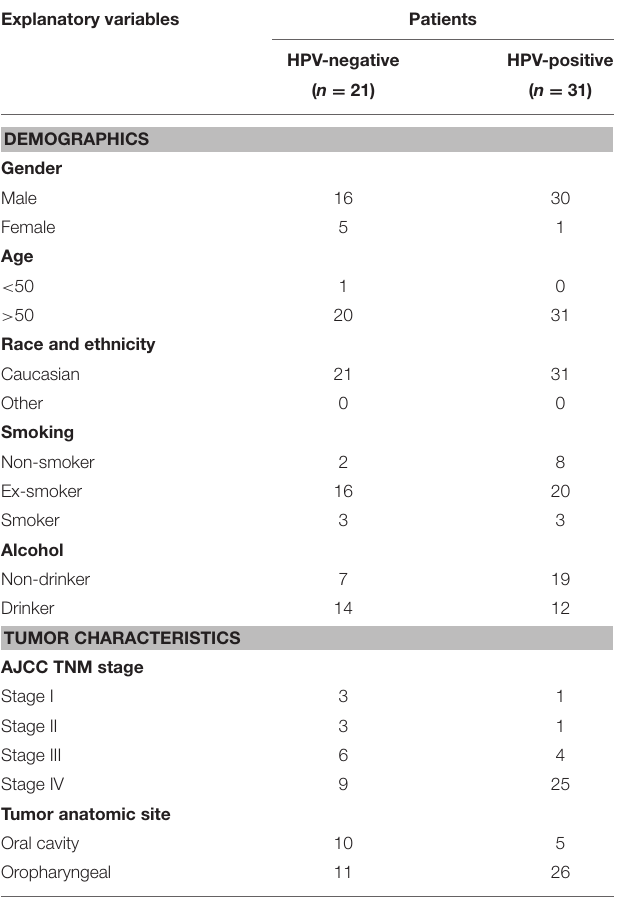
TABLE 1 | The demographic characteristics of the patient cohort ( n = 52).